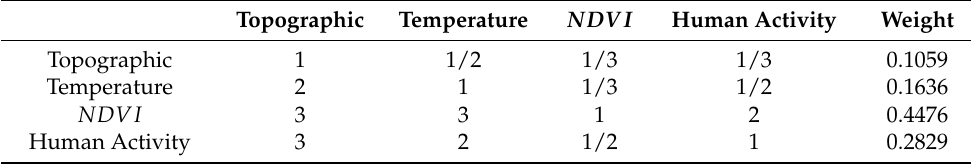
Table 11. The weight allocation of each type.